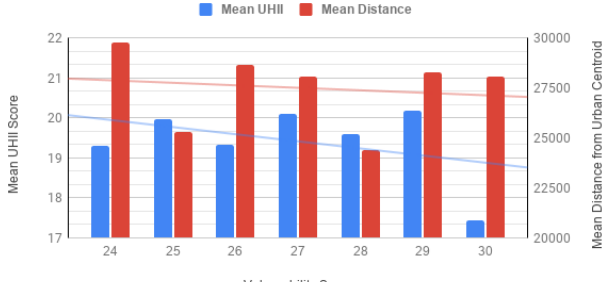
Figure 9 - Mean UHII and distance from Dallas’s urban center for blocks with the top 25% of vulnerability scores.